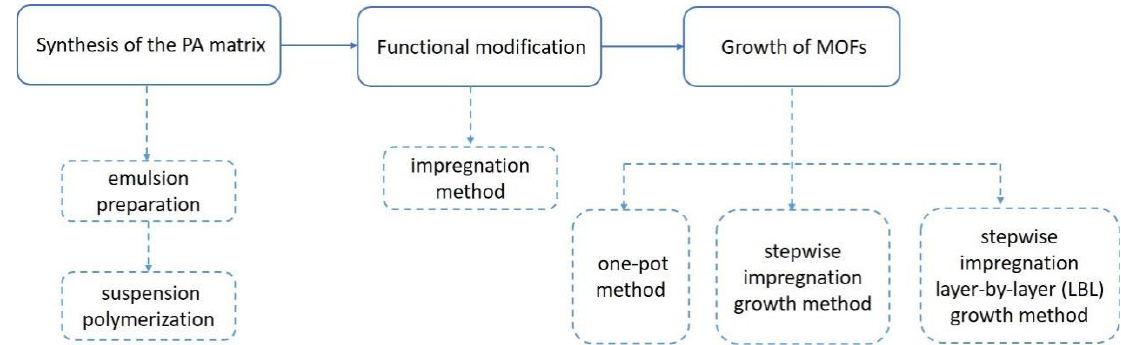
Figure 9. The schematic diagram for the synthesis process of MOF@PA-PEI.